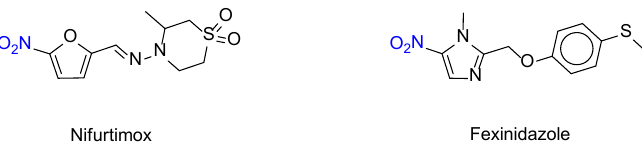
Figure 1. Structure of nitro-containing drugs used in the treatment of HAT.